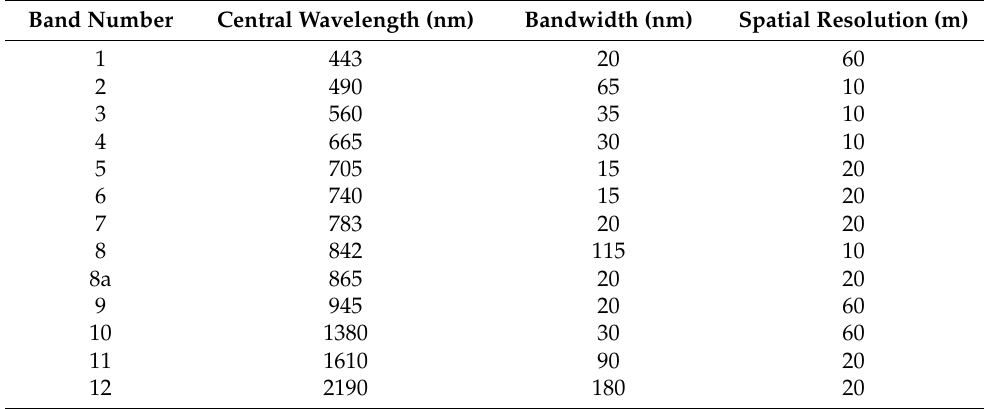
Table 1. Main characteristics of S2-MSI spectral bands